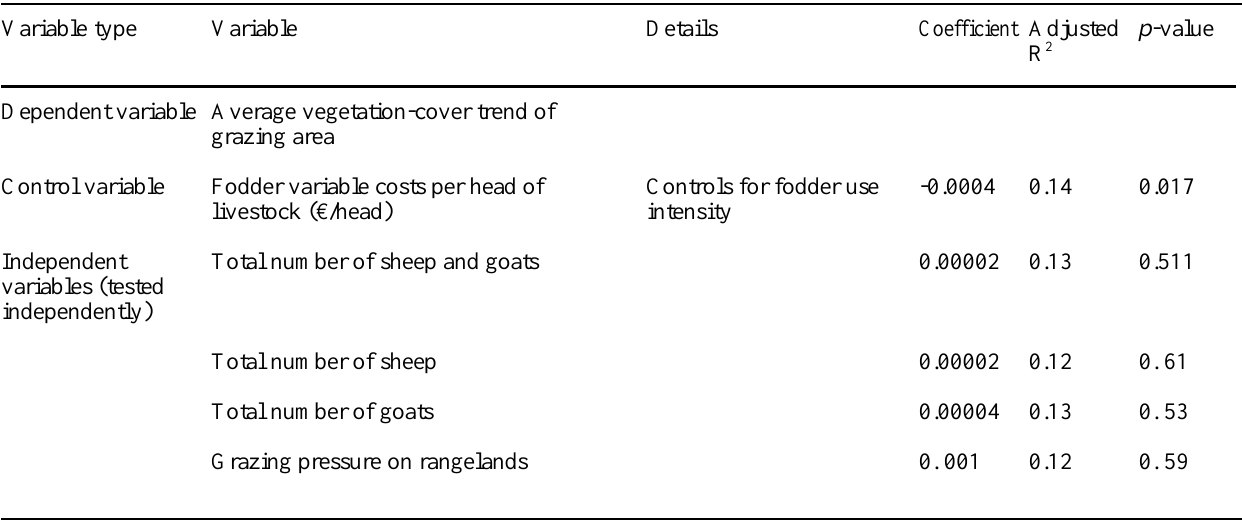
Table 7. Linear regression results for stock number and grazing pressure as explanatory variables for average vegetation-cover trend of grazing areas ( n =